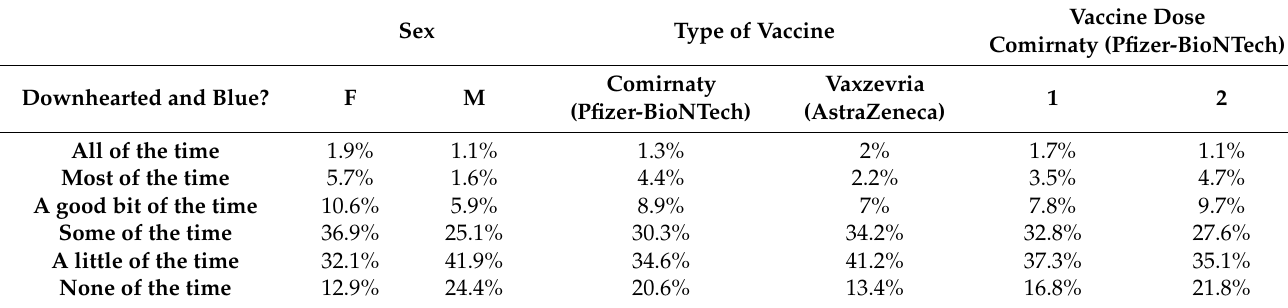
Table 4. Percentage of response frequencies related to item #11 of the SF-12 divided by variable.